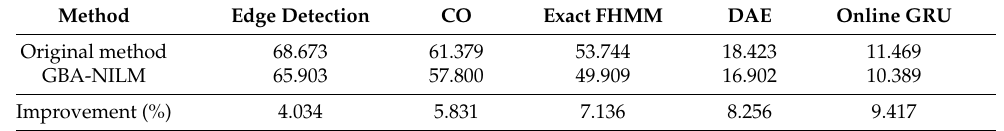
Table 4. Improvements of GBA-NILM over the original model in terms of the MAE